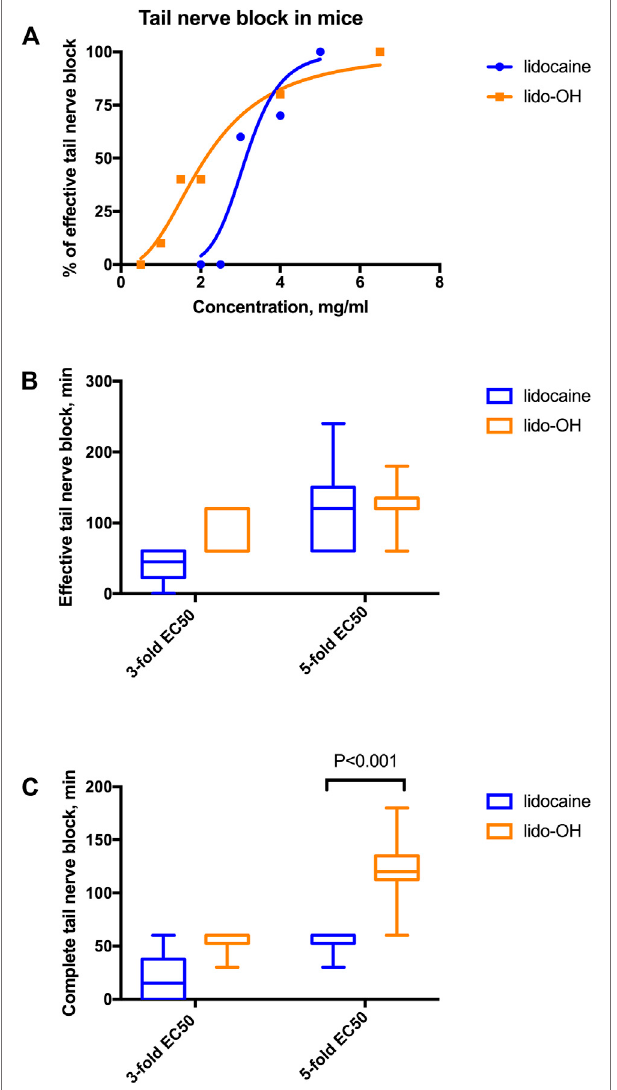
FIGURE2| Theactionoflido-OHandlidocaineinmicetailnerveblock(n (cid:1) 10): The concentration-response curve (A) ; duration of effective (B) and complete (C) tail nerve block.EC 50 for lidocaine: 3.1 mg/ml, EC 50 for lido-OH: 2.1 mg/ml.